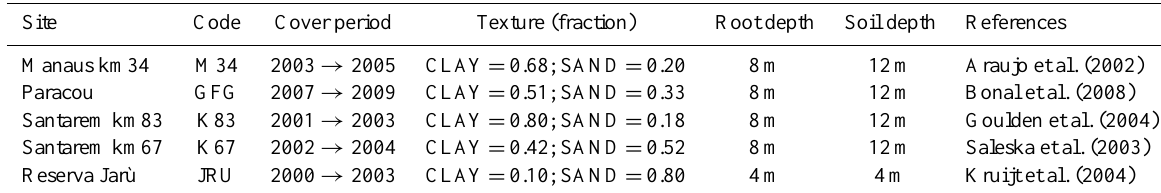
Figure 1. Mean annual cycle of precipitation (blue) and temperature (red) calculated over 3 years (see Table 1), and the location of the flux towers used in this study. Table 1. Characteristics and references of flux towers used in this